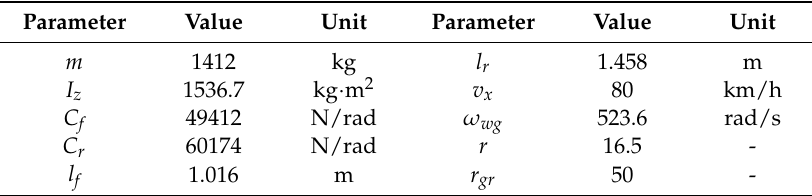
Figure 9. Design of fuzzy-PID strategy for AFS system: ( a ) flowchart; and ( b ) compositional rule of inference for the fuzzy controller. Table 2. Parameters of the proposed AFS system with the VGRS actuator.